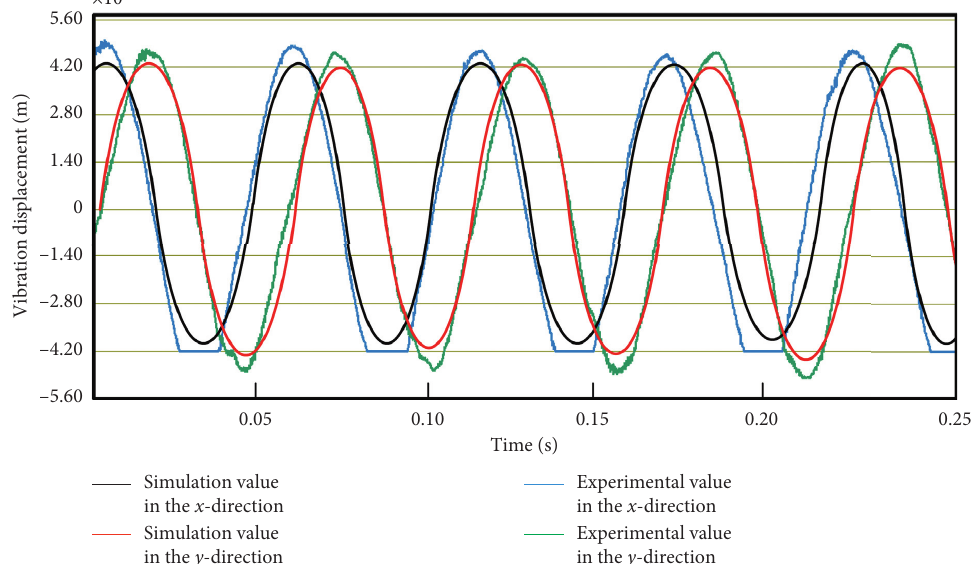
Figure 17: Comparison of experimental values and simulated values of radial vibration displacement at 1200 r/min.